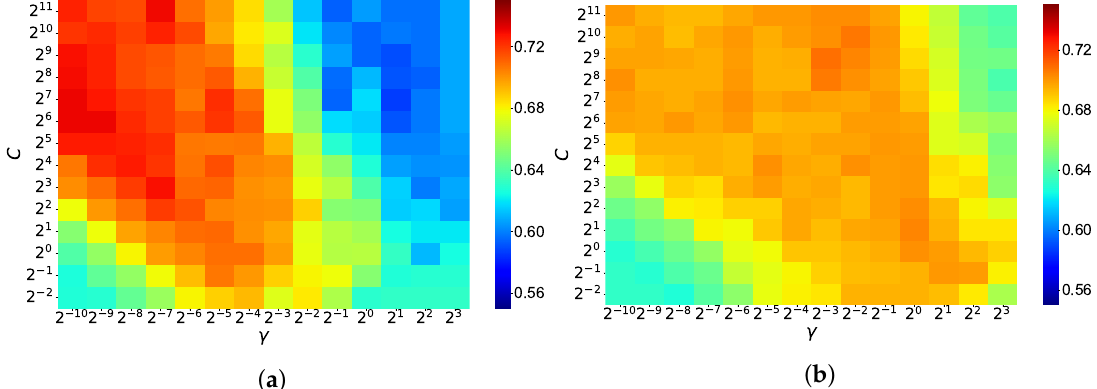
Figure 7. ( a ) Grid search result of the SVM. Classification accuracies are denoted by color. The optimal hyperparameters were C = 2 6 and γ = 2 − 9 ; ( b ) grid search result of the SVM. Classification accuracies are denoted by color. The optimal hyperparameters were C = 2 9 and γ = 2 − 3 .